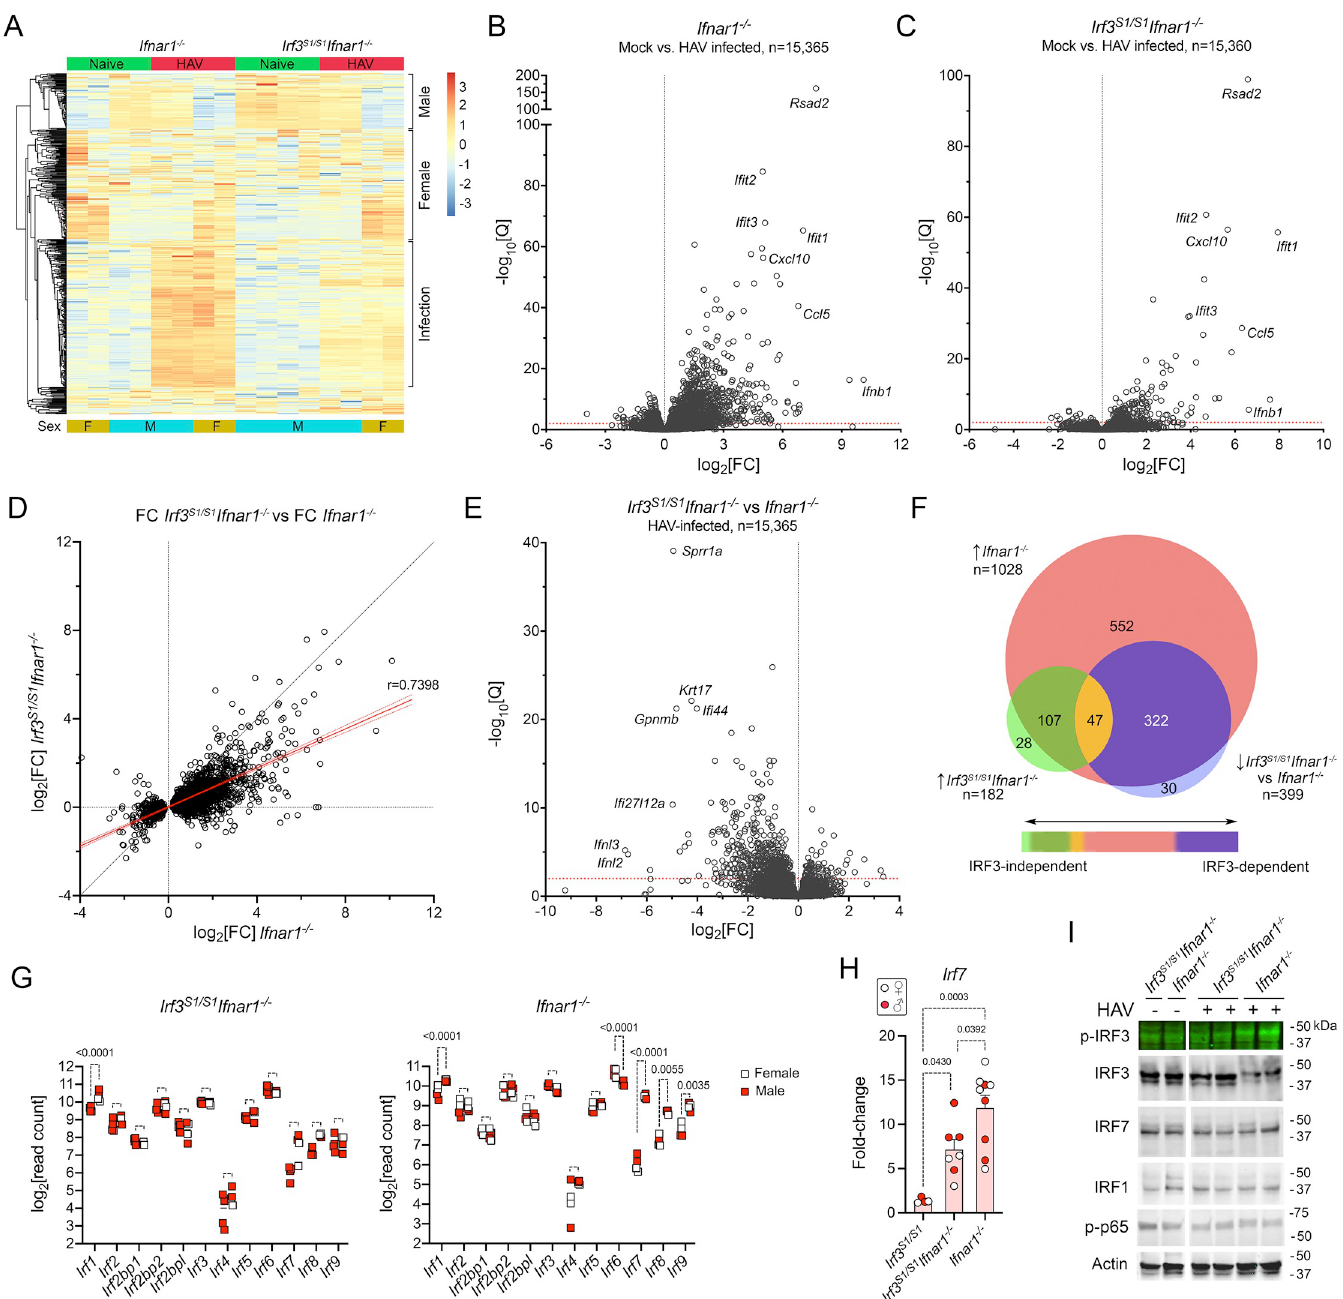
Fig 4. Changes in the intrahepatic transcriptome of HAV-infected Irf3 S1/S1 Ifnar1 -/- mice. (A) Heat map showing changes in abundance of the top 500 differentially- expressed genes (ranked by variance of standardized read counts) in na ï ve and HAV-infected Irf3 S1/S1 Ifnar1 -/- and Ifnar1 -/- mice; n = 4 in each group selected for high- throughput RNA sequencing. Transcripts differentially expressed in relation to sex or HAV infection are noted on the right. The scale on the right represents z-score. (B, C) Volcano plots showing fold-change (fc) and significance of changes in transcripts of genes with at least 10 reads mapped in RNA from na ï ve versus HAV-infected liver tissue from (B) Ifnar1 -/- and (C) Irf3 S1/S1 Ifnar1 -/- mice. Q = adjusted p-value. (D) Correlation of fold-change (log 2 [FC]) observed in abundance of 2,503 differentially expressed transcripts in HAV-infected Irf3 S1/S1 Ifnar1 -/- mice versus Ifnar1 -/- mice. Red line = simple linear regression, ± 95% C.I.; slope = 0.4415; Spearman r = 0.7398, p < 0.0001. (E) Volcano plot showing fold-change and significance of infection-induced differences in intrahepatic RNA transcripts in Irf3 S1/S1 Ifnar1 -/- versus Ifnar1 -/- mice. (F) Venn diagram showing overlap of genes upregulated by infection in Ifnar1 -/- and Irf3 S1/S1 Ifnar1 -/- mice. (G) Normalized read counts of interferon regulatory factor transcripts in mock versus HAV-infected ( left ) Irf3 S1/S1 Ifnar1 -/- and ( right ) Ifnar1 -/- mice. Significance determined by two-way ANOVA with Sˇı´da´k’s multiple comparisons test. (H) Infection induced fold-change in Irf7 transcript abundance determined by RT-qPCR. Fold increase for Irf3 S1/S1 was 1.38 ± 0.31 s.d. Solid red symbols represent male animals. (I) Immunoblots of interferon regulatory factors, including phosphorylated IRF3 (p-IRF3, Ser396), and phosphorylated RELA (p- p65) in extracts of liver tissue from na ï ve and HAV-infected ( left ) Irf3 S1/S1 Ifnar1 -/- and ( right ) Ifnar1 -/- mice.